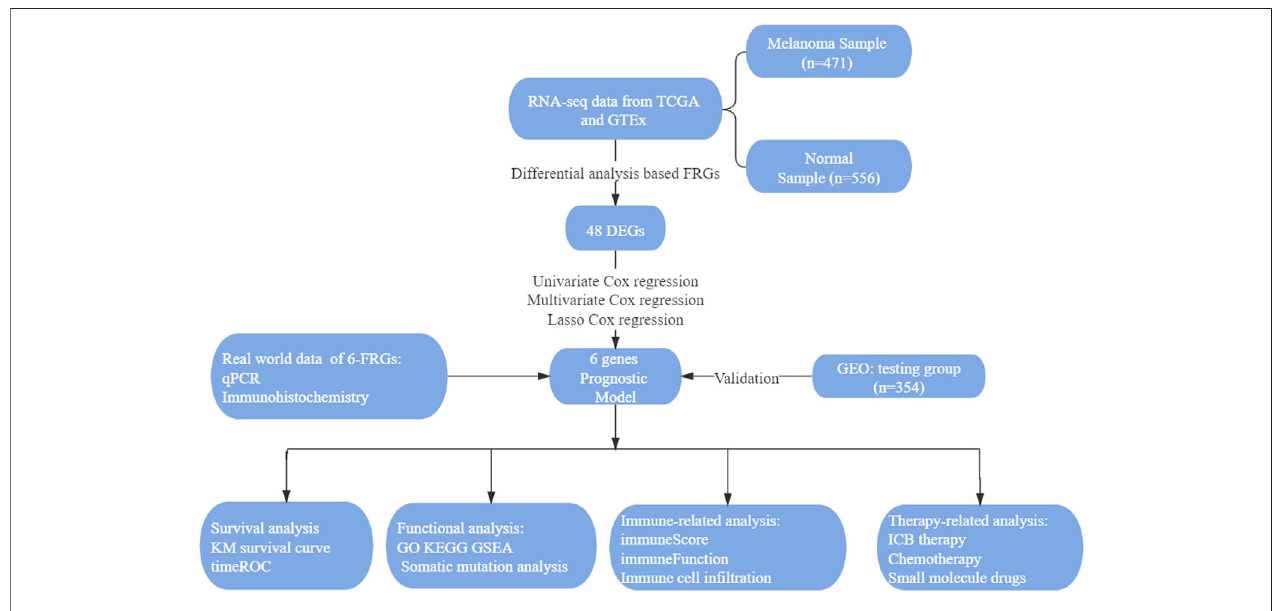
FIGURE 1 | The visual fl ow-process diagram of this